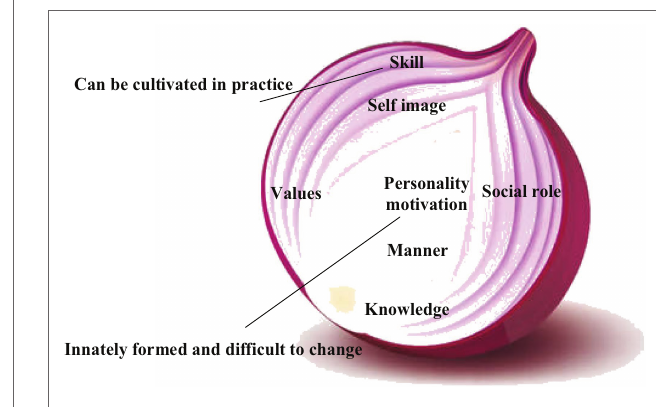
FIGURE 1 | Iceberg model of talent characteristics. FIGURE 2 | Onion model diagram of talent